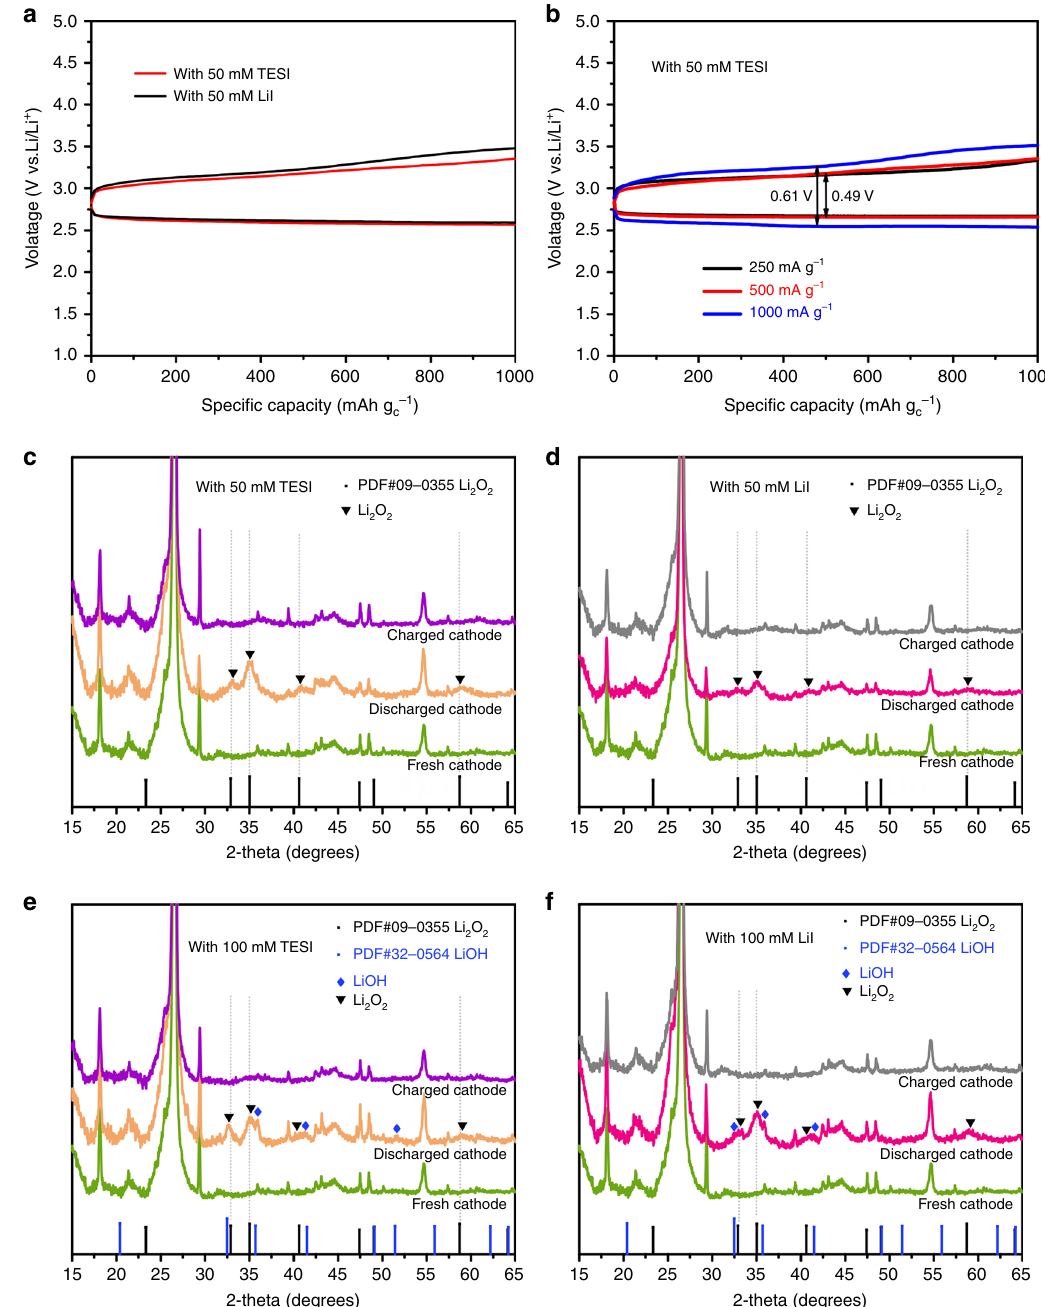
Fig. 2 Electrochemical performance and XRD patterns of the Li-O 2 cells with TESI or LiI additives. a Galvanostatic discharge/charge pro fi le at 500 mA g − 1 with 50 mM TESI or 50 mM LiI additives at a limited speci fi c capacity of 1000 mAh g − 1 . b With 50 mM TESI additive for the fi rst cycle, current density: 250, 500 and 1000 mA g − 1 . XRD patterns of the cathode at the end of discharge and the cathode at the end of charge with ( c ) 50 mM TESI additive, ( d ) with 50 mM LiI additive, ( e ) with 100 mM TESI additive, ( f ) with 100 mM LiI